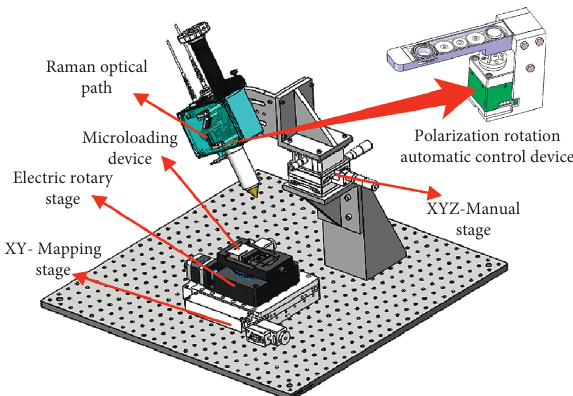
Figure 16: Assembly diagram of self-built angle-resolved polari- zation Raman